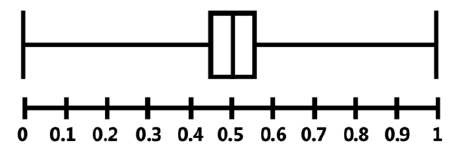
Figure 4. Box plot for subjectivity score of words in Sanders dataset.